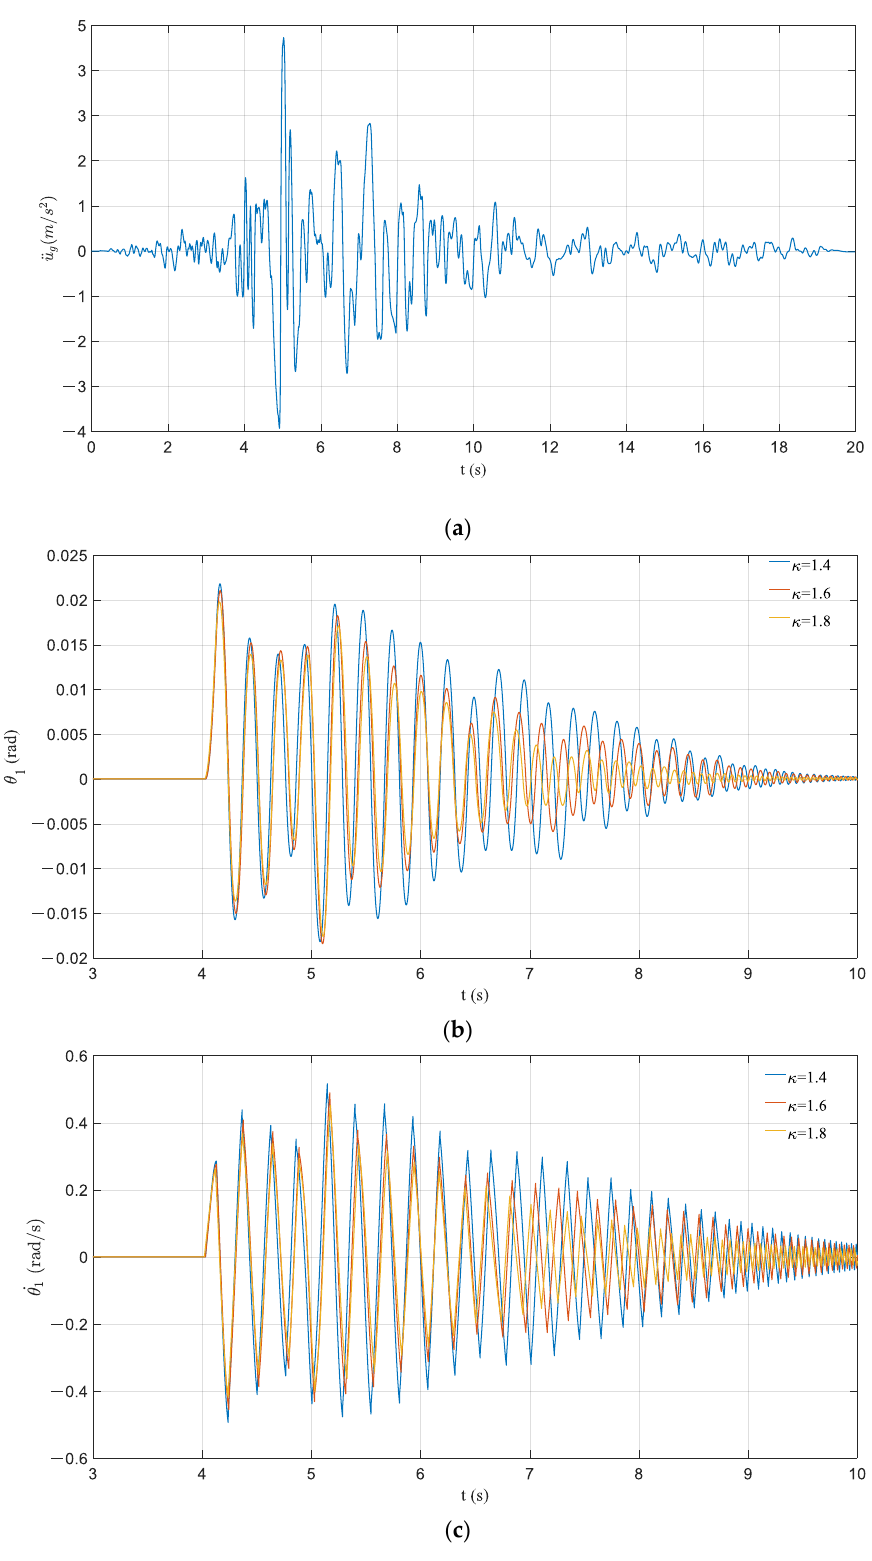
Figure 13. Effect of variation in κ for the case of ER2: ( a ) time history of earthquake record ER2; ( b ) time history of rocking rotation; ( c ) time history of angular